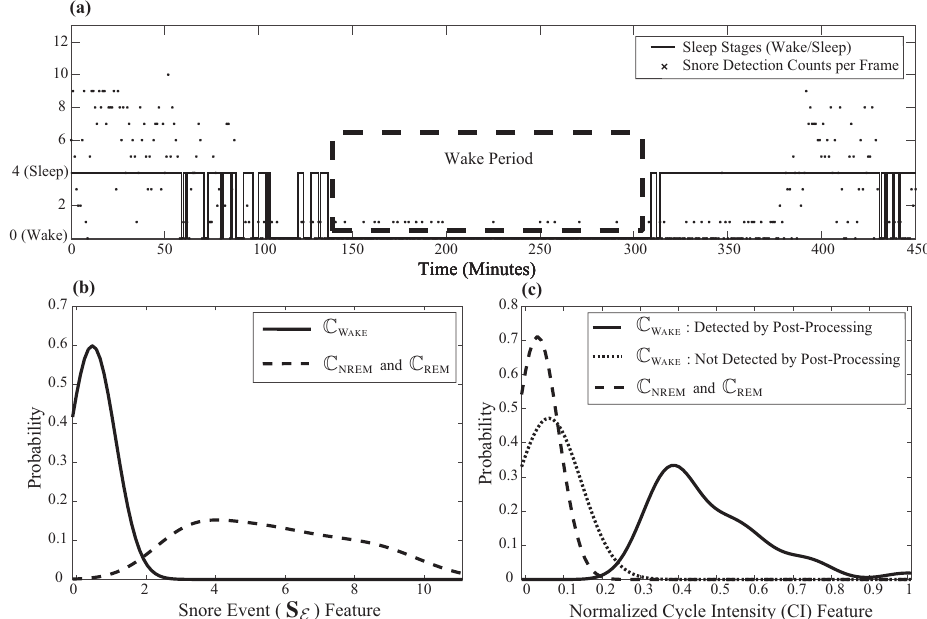
Figure 4. The effect of sound features on wake/sleep classification: ( a ) The detection of snore event features during the wake and sleep class. ( b ) The distribution of snore event feature with respect to the wake and sleep (NREM and REM) class. ( c ) The distribution of the normalized cycle intensity (CI) feature during the wake and sleep class. The solid line describes that the post-processing clearly separates the distribution of the normalized CI feature in the wake class with respect to the sleep